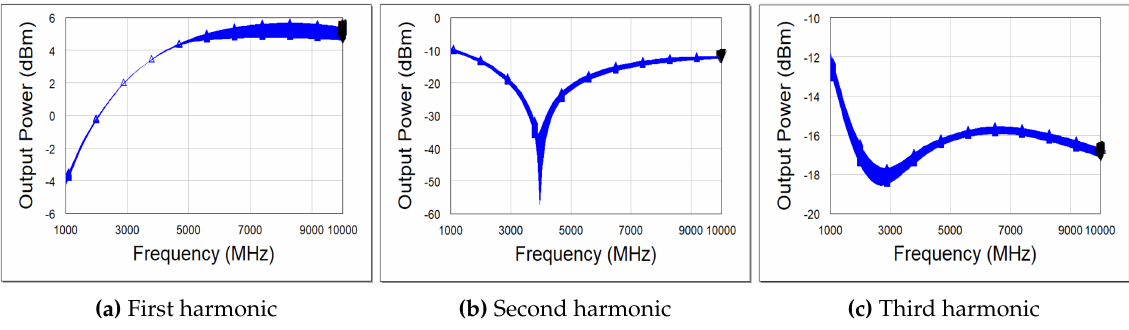
Figure 4. Received powers at first three harmonics of the common emitter amplifier circuits.